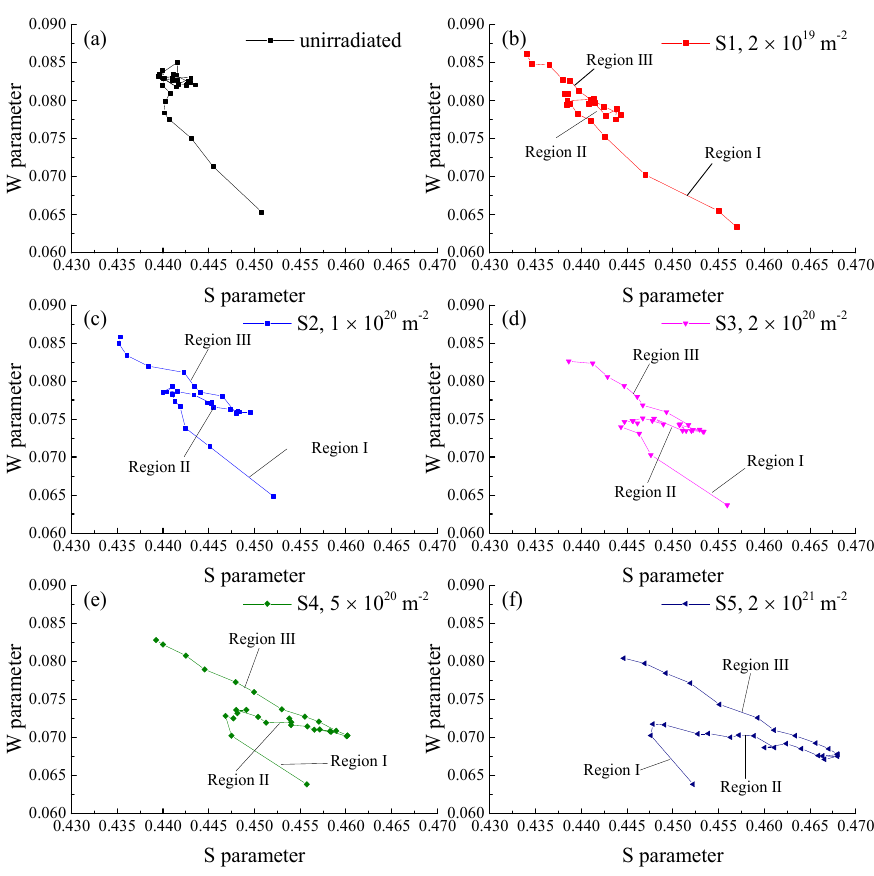
Figure 3. S–W curves for ( a ) the unirradiated specimen and specimens (S1–S5) irradiated at 523 K to different fluences: ( b ) 2 × 10 19 , ( c ) 1 × 10 20 , ( d ) 2 × 10 20 , ( e ) 5 × 10 20 , and ( f ) 2 × 10 21 m − 2 .